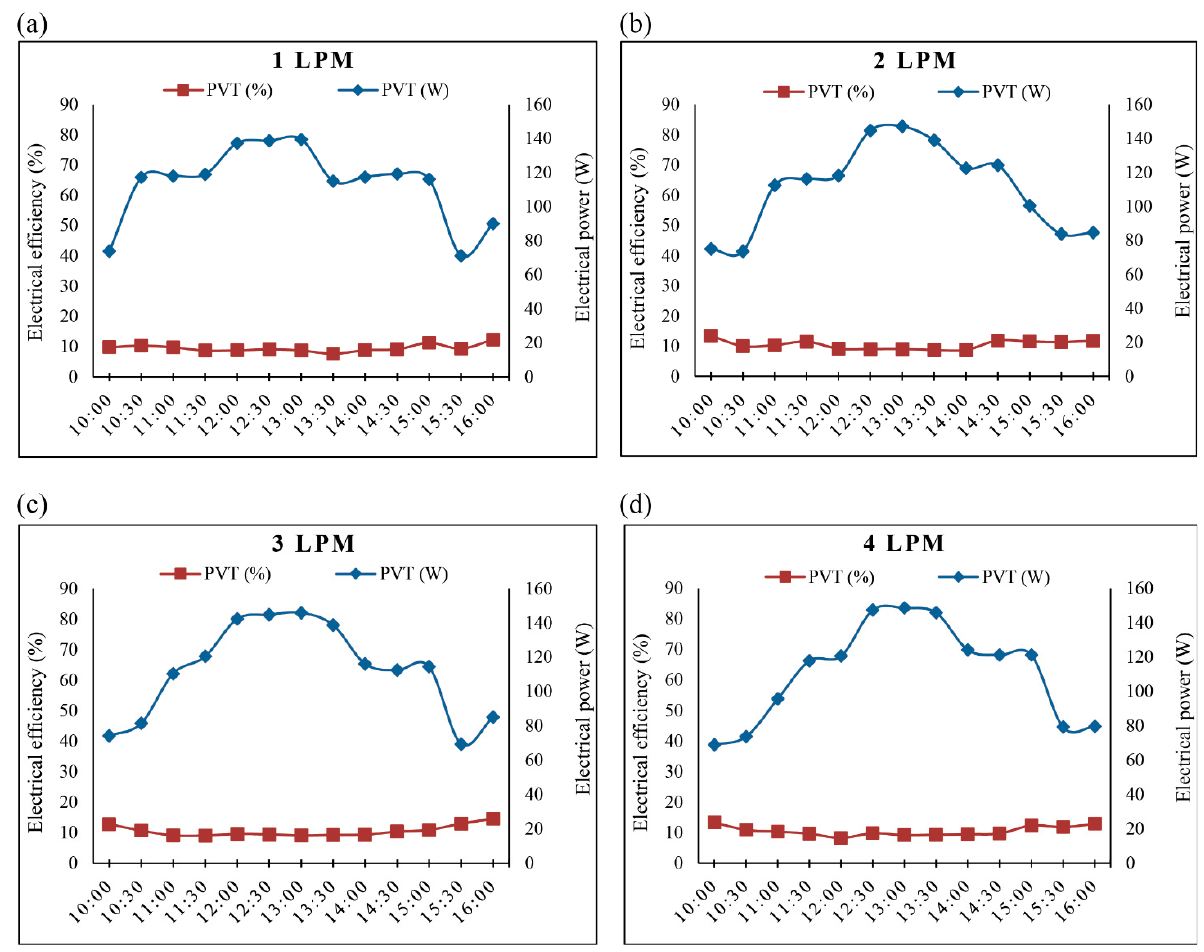
Figure 4. Electrical performance of PVT system at ( a ) 1 LPM, ( b ) 2 LPM, ( c ) 3 LPM, and ( d ) 4 LPM flow rate.